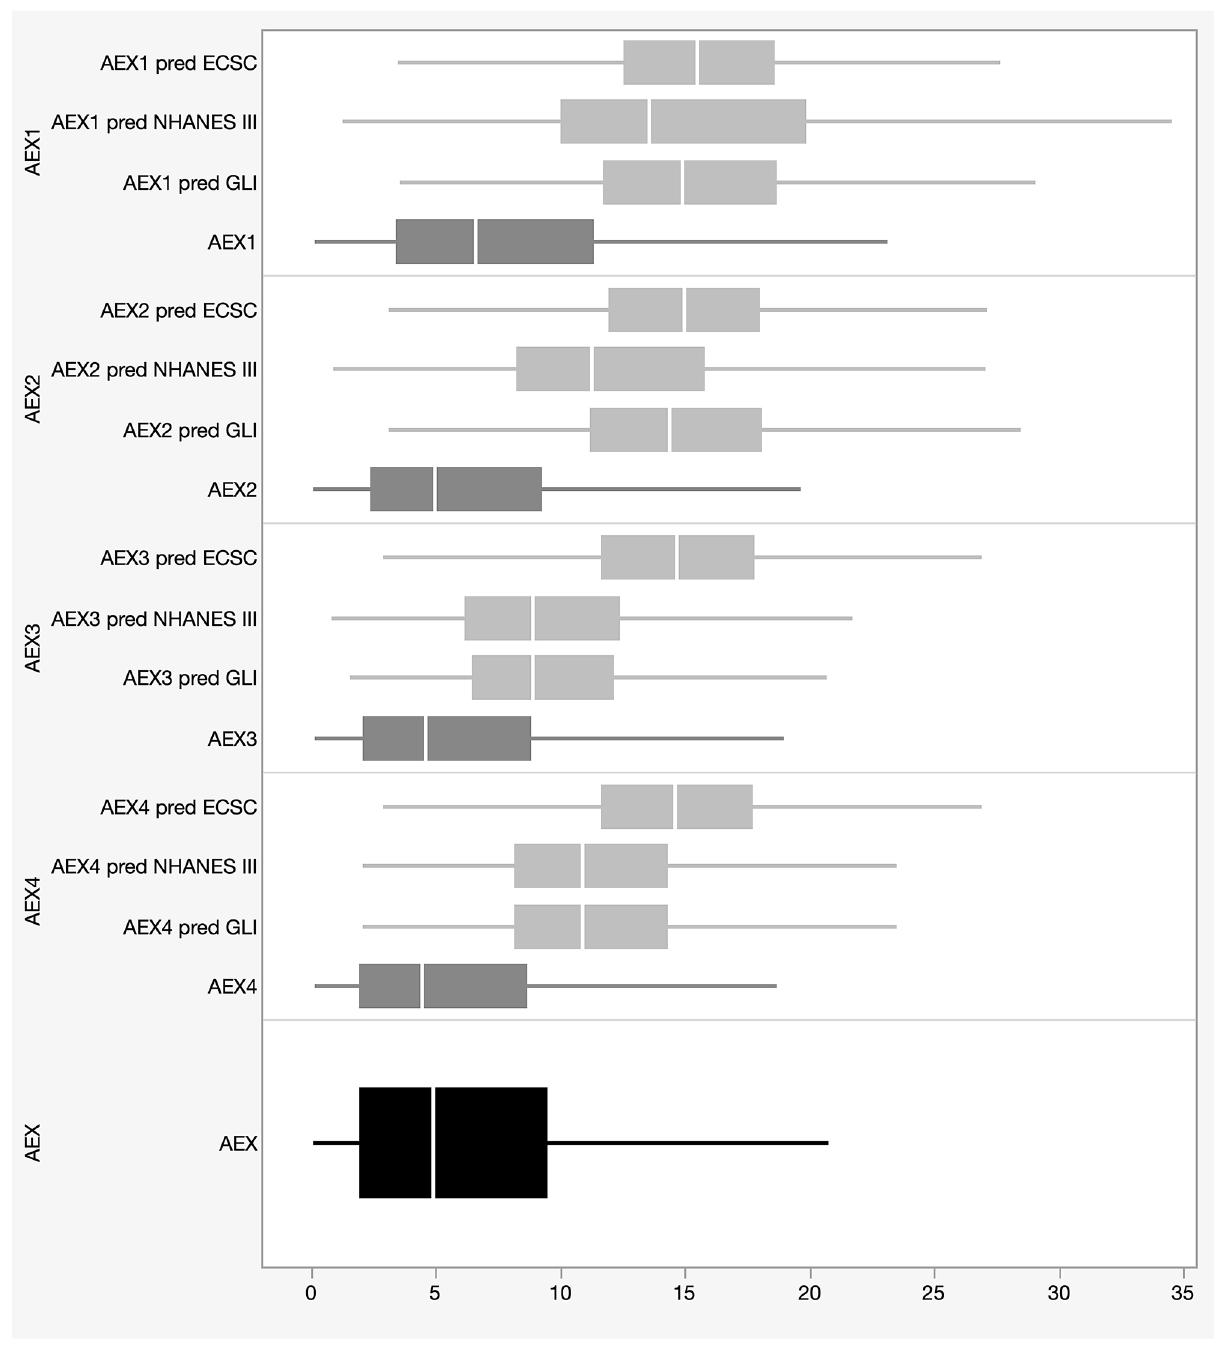
Figure 3. Box-and-whisker plots of AEX and AEX 1 through AEX 4 by ECSC, NHANES III and GLI predicted equations (Tukey–Kramer and Welch ANOVA tests: p < 0.0001). AEX area under expiratory flow-volume curve, ECSC European Community of Steel and Coal, GLI global lung initiative, NHANES III National Health and Nutrition Examination Survey were not progressively larger at higher values. The model’s R 2 ranged from 0.80 and 0.83 in the derivation/training and the internal validation/testing sets, and 0.55 in the external validation set (Fig. 5a). These were much higher than prior models’ R 2 (regression-based), which ranged from 0.39 to 0.42 11 . More importantly, other measure- ments of model error (Fig. 5a) remained lower vs other regression techniques used. By contrast, in our analyses, the regression-based predicted AEX had a median difference of 0.12 (IQR − 1.90 to 2.03) L 2 /s, and a correlation coefficient of 0.86; in the external validation lot (Madrid group), the median difference was − 1.04 (IQR − 2.73 to 1.21) L 2 /s, and the correlation coefficient was 0.78. Similarly, in our ANN models, the AEX z score predic- tion, which is important for determining LLN, was also very robust (Fig. 5b). While all inputs were significant independent predictors, the most important factors (total effects, %) for predicted AEX were gender (28.6%),